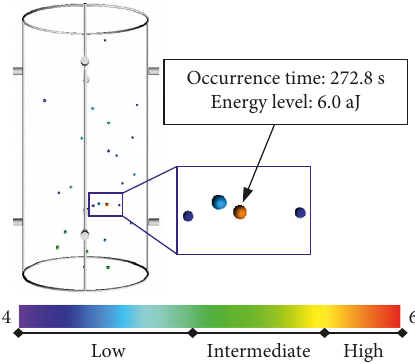
Figure 12: The spatial distribution of the AE events from 0s to 272.8s in